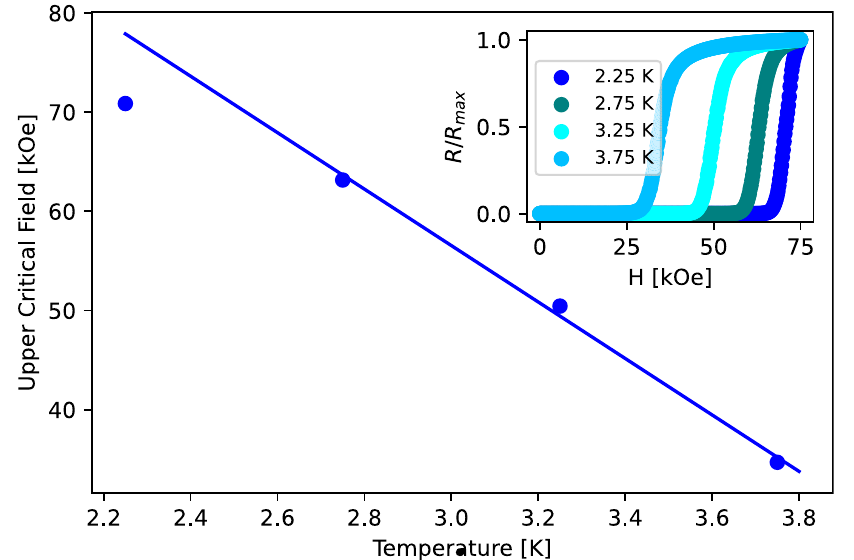
Figure 3. Perpendicular upper critical field H c 2 measured as a function of temperature for a 300 nm IBAS thin film deposited at 4 sccm. Inset: Normalized resistance measurements of the same film as a function of the applied field at temperatures close to T c